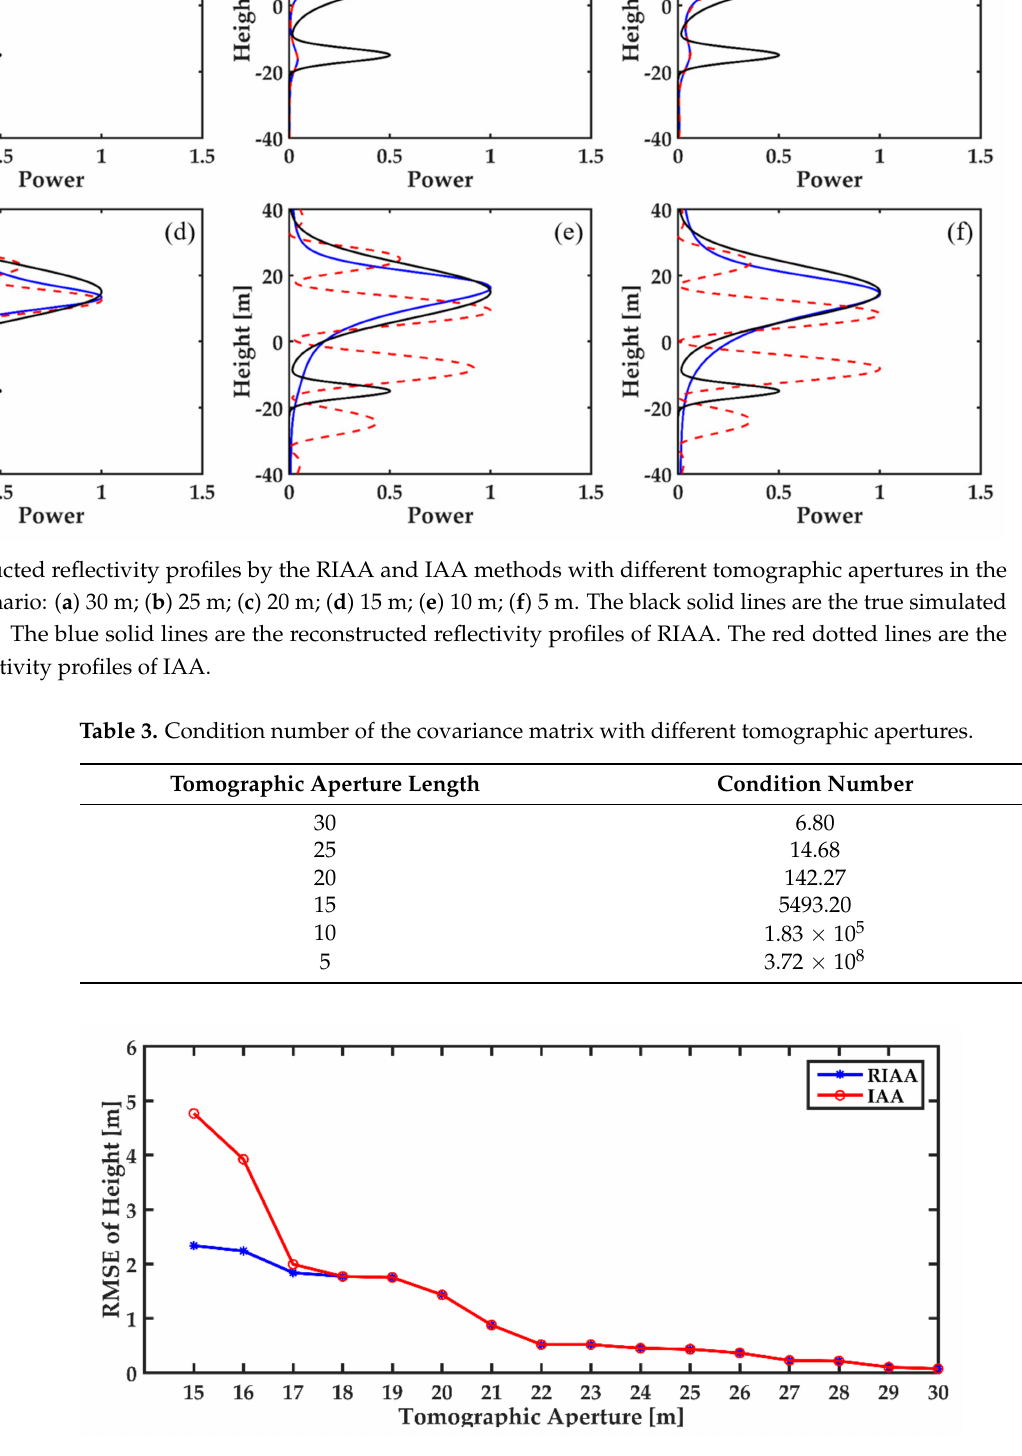
Figure 5. RMSEs of scattering phase center height estimated by RIAA and IAA methods with different tomographic